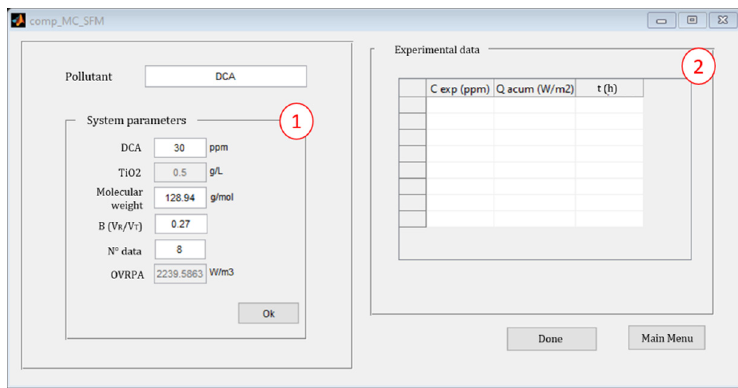
Figure 5. Input panel for the kinetic modeling module. (1) System parameters panel; (2) experimental data panel.